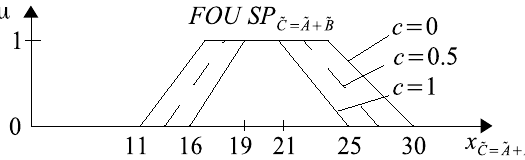
of 5D-result of C = ˜ A + ˜ B